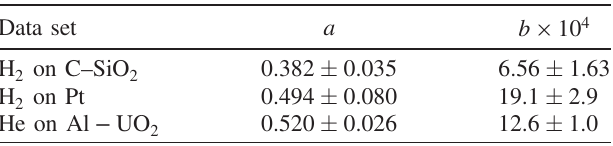
TABLE I. Fitting parameters a and b for the exponent α ð T s Þ ¼ a exp ð − bT s Þ reproducing the data shown in Fig. 4.